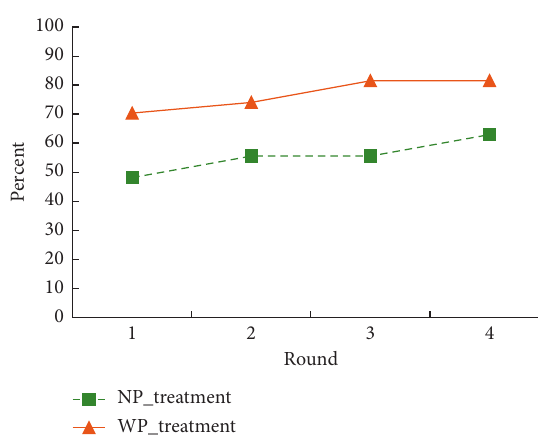
Figure 3: Success rates of cooperation of enterprise